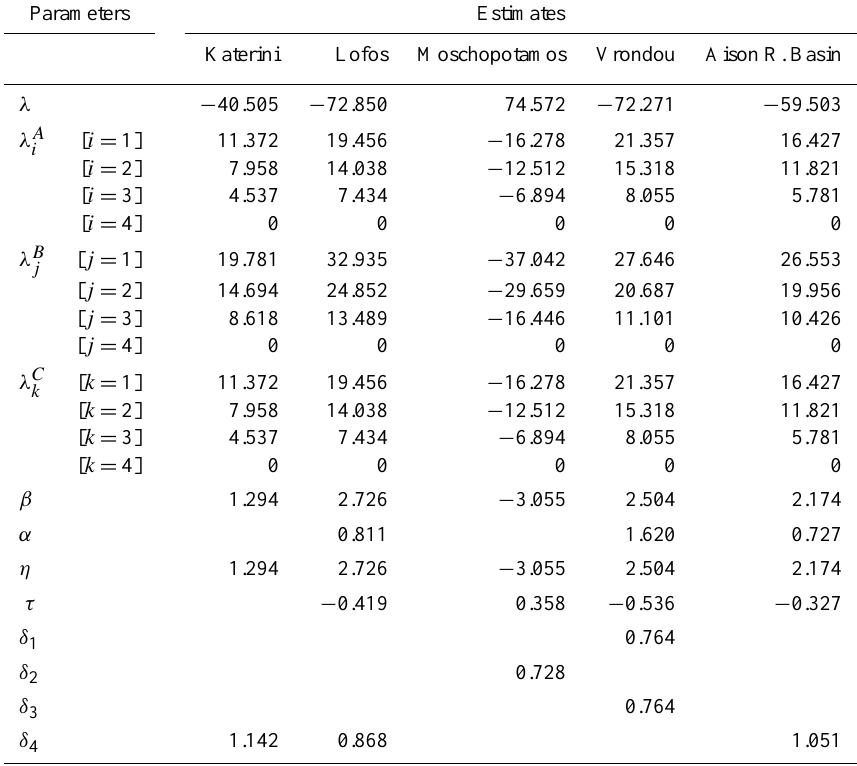
Table 6. Estimated parameter values. Parameters